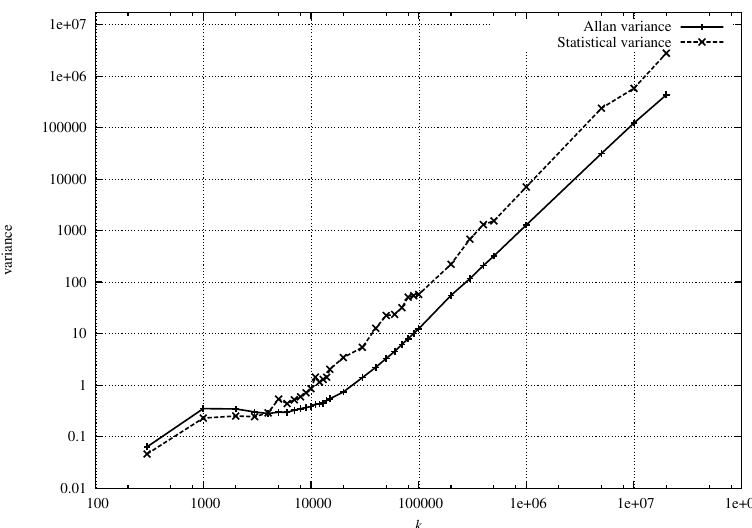
Figure 7: Variance and Allan variance of counter values depending on the measurement interval k , with two ROs as sources of the jittery clock